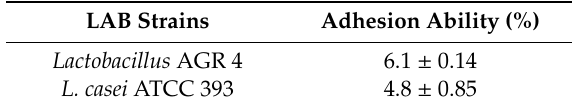
Table 2. Adhesion capacity of Lactobacillus AGR 4 onto HT-29 cells, assessed by quantitative